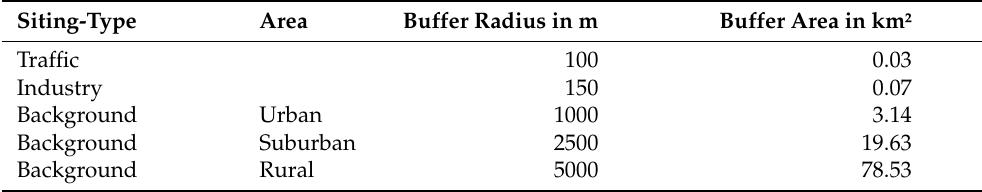
Table 1. Buffer radii configurations according to Annex III of the directive 2008/50/EC for different siting-types and their surrounding areas.